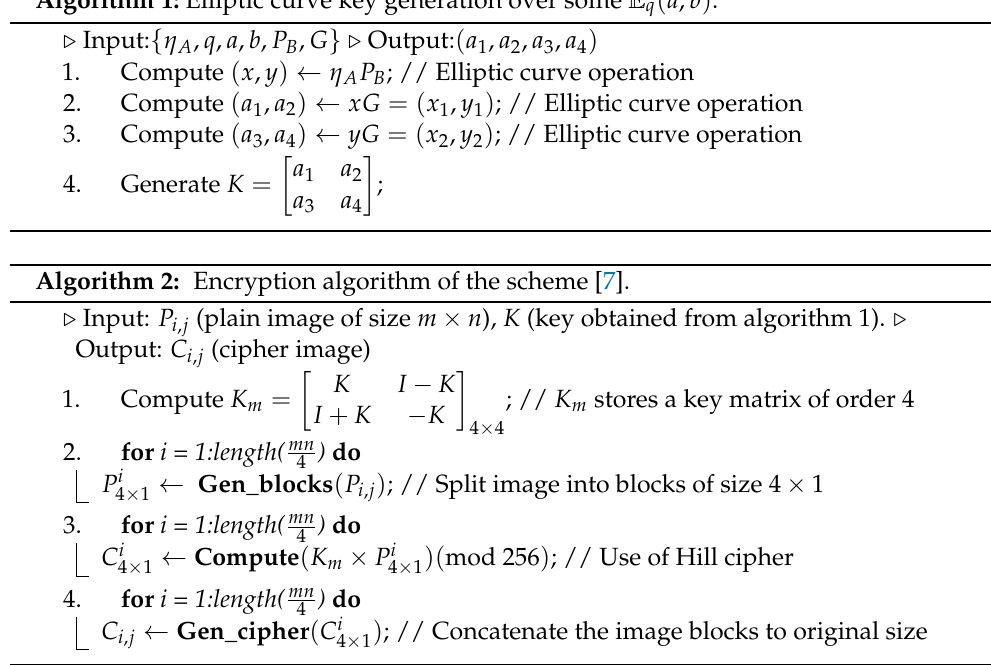
Algorithm 1: Elliptic curve key generation over some E q ( a , b ) .